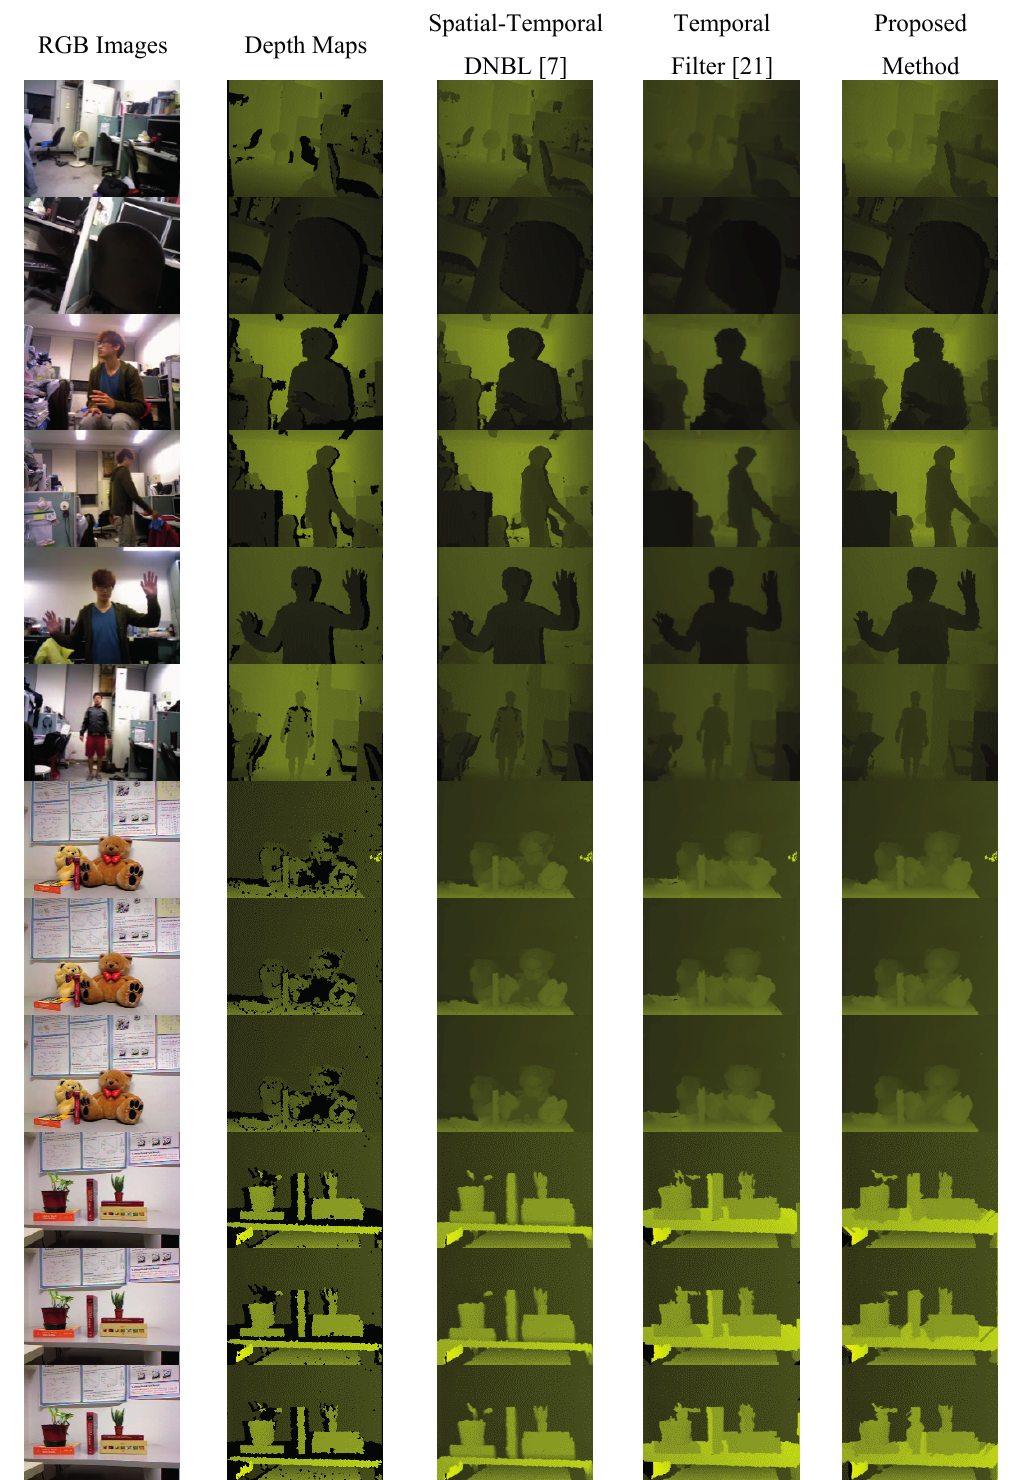
Figure 7. Real-world database and Milani’s Kinect